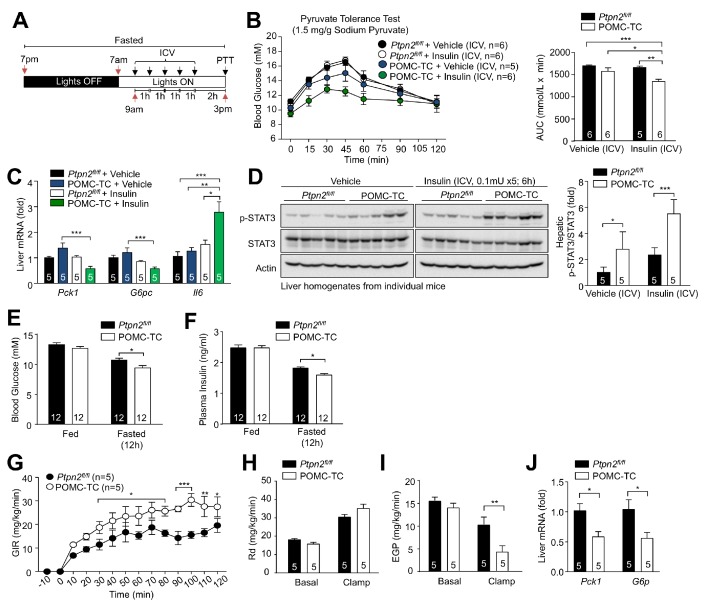
Elevated TCPTP in POMC neurons in obesity promotes HGP and systemic insulin resistance.(a) Experimental paradigm schematic. (b) Ptpn2fl/fl or POMC-TC male mice were high fat fed (HFF) for 12 weeks and after an overnight fast ICV administered saline or 0.1 mU/animal (5 x injections over 5 hr) and subjected 1 hr later to either (b) a pyruvate tolerance test (1.5 mg/g) or livers extracted for (c) quantitative PCR or (d) immunoblotting; areas under curves were determined and significance determined using a one-way ANOVA followed by Tukey multiple comparison test, or a two-way ANOVA followed by Sidak multiple comparison test. Ptpn2fl/fl or POMC-TC male mice were HFF for 12 weeks and fed and fasted (e) blood glucose and (f) plasma insulin levels were assessed; significance was determined using a two-way ANOVA followed by Sidak multiple comparison test. Ptpn2fl/fl or POMC-TC male mice were HFF for 12–14 weeks and subjected to hyperinsulinemic-euglycemic conscious clamps. (g) Glucose infusion rates (GIR; analysed by two-way ANOVA with repeated measures followed by Sidak multiple comparison test), (h) glucose disappearance rates (Rd) and (i) basal and clamped endogenous glucose production (EGP; glucose appearance rate minus GIR) were determined and (j) livers extracted for quantitative PCR (analysed using a two-tailed t-test or a two-way ANOVA followed by Sidak multiple comparison test). Representative and quantified results are shown (means ± SEM) for the indicated number of mice.